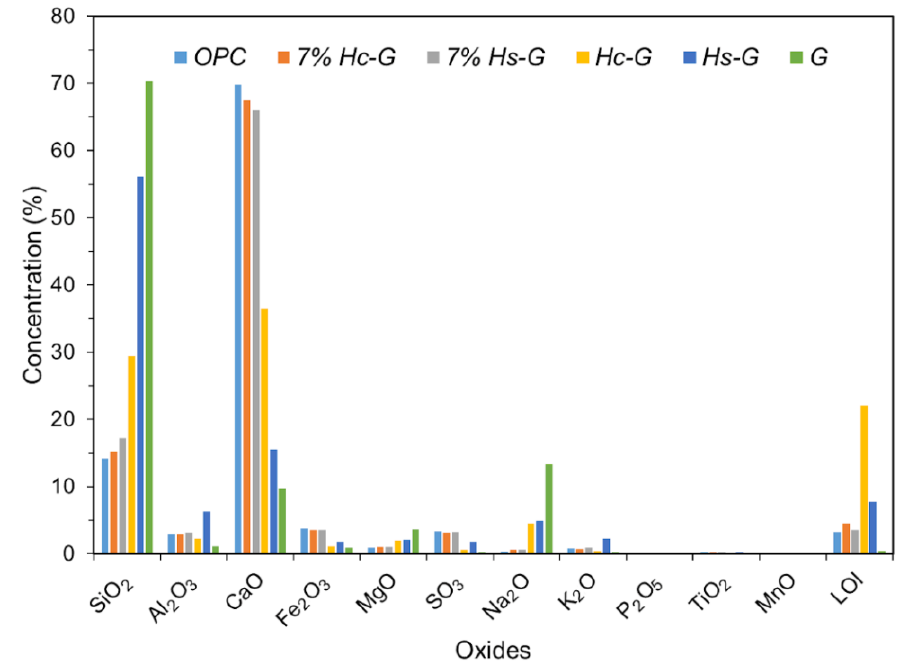
Figure 2. XRF-determined chemical composition of the samples analyzed. Table 2. Laser-determined D10, D50 and D90 values for the samples studied.